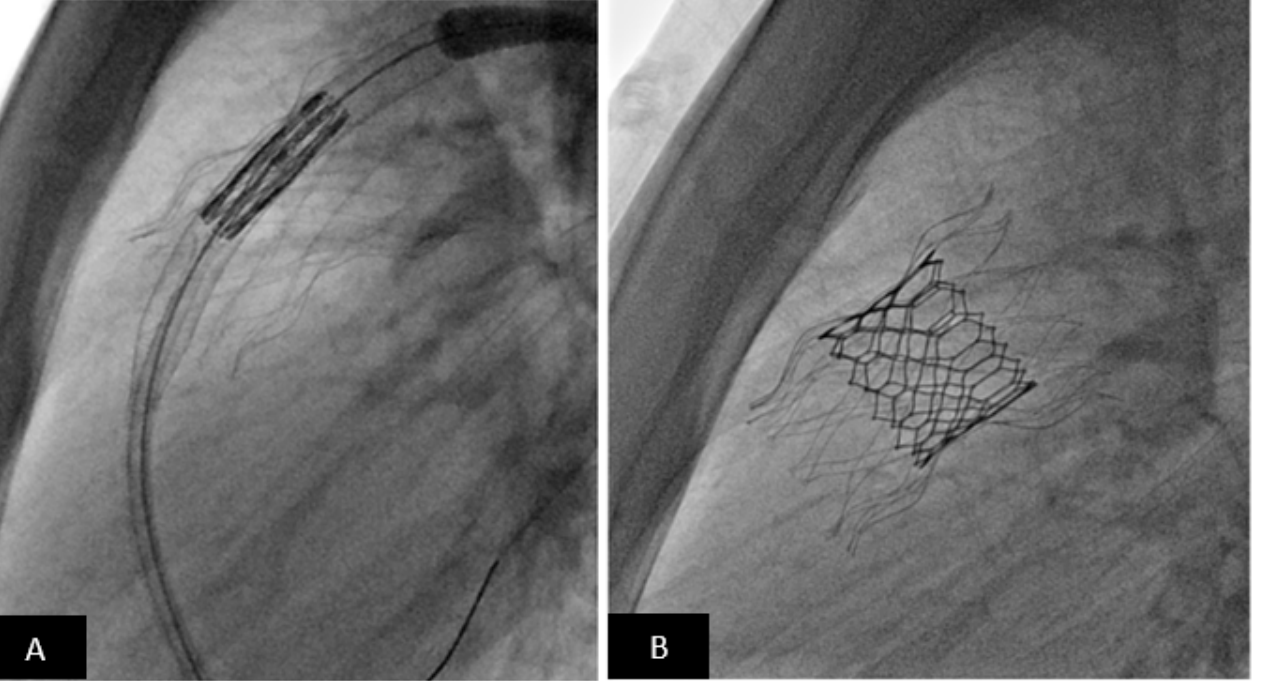
Figure 11. Transcatheter pulmonary valve replacement using Alterra pre-stent with Edwards-Sapien S3 TPV. ( A ) Lateral fluoroscopy projection showing Alterra Pre-stent (light stent frame) deployed. The Sapien S3 valve is positioned for deployment. ( B ) Lateral fluoroscopy projection showing the Sapien S3 valve (dark frame) deployed inside the Alterra Pre-stent (light frame).